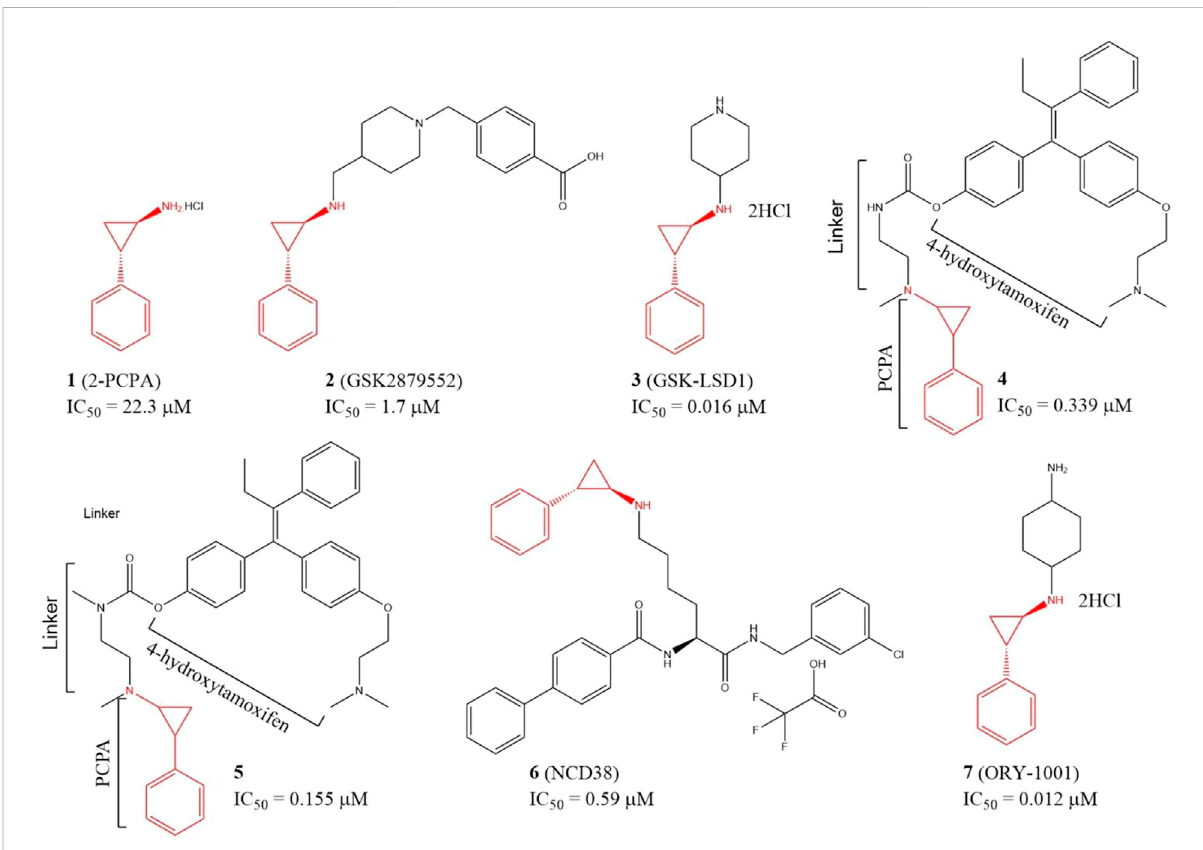
FIGURE 4 Chemical structures of PCPA-based LSD1 inhibitors in BC therapy.